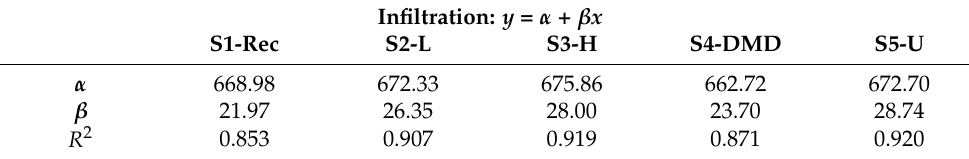
Table 9. Summary of infiltration regression equations.